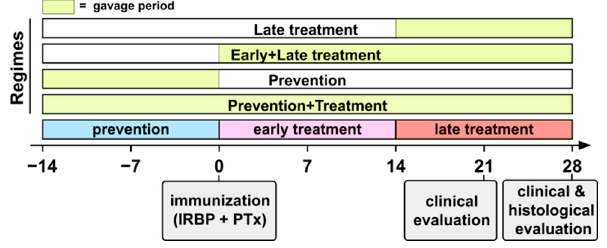
Figure 1. Experimental schedules.